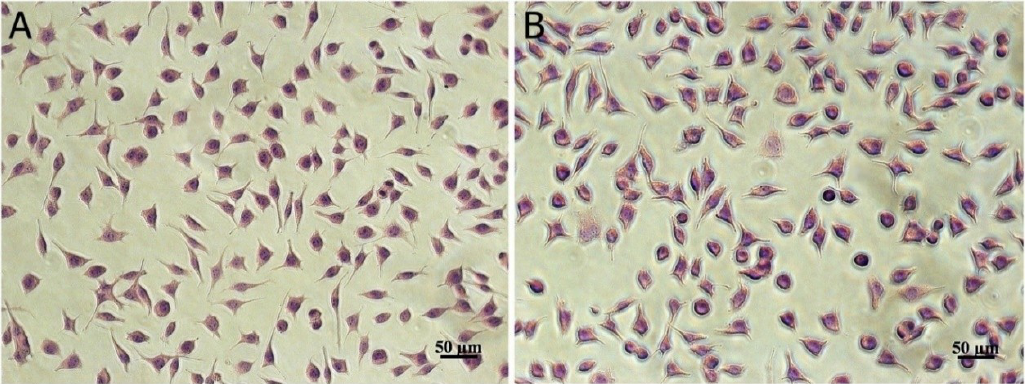
Figure 3. Light micrograph of L929 fibroblasts treated with 0.05 mg / mL microencapsulated sample ( B ) indicating similar cell morphology to untreated control cells ( A ), after 24 h of cultivation in standard conditions. Giemsa staining. Scale bar = 50 µm.